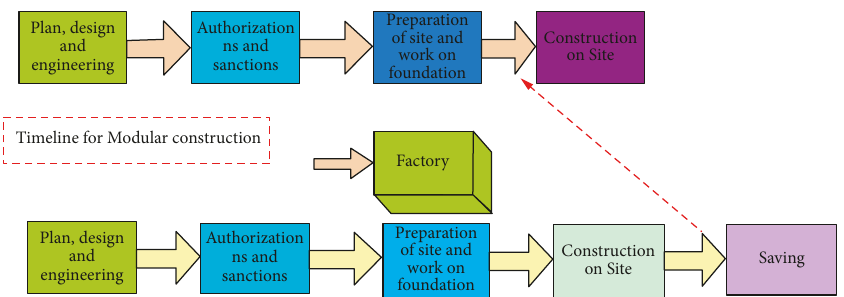
Figure 4: Comparison of modular construction schedule and site build construction